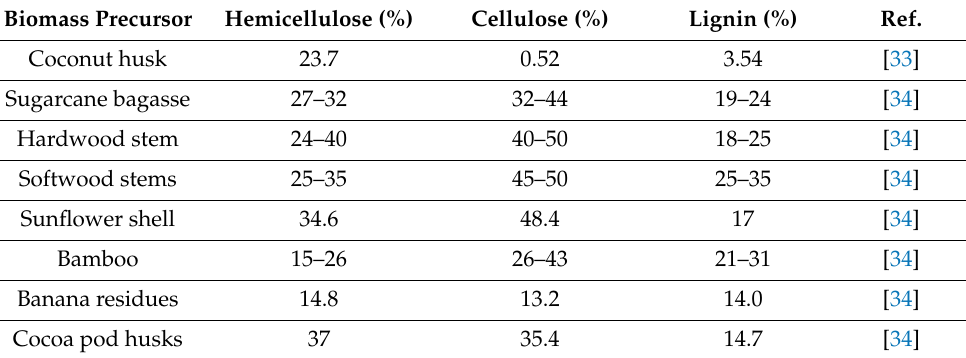
Table 1. Main composition of some agricultural biomass and